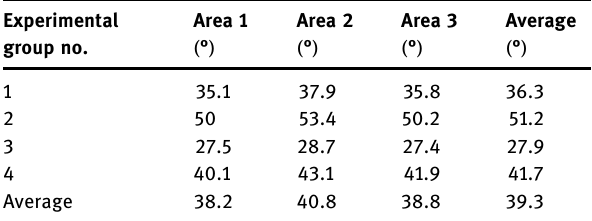
Table 2: Statistical data of braiding angles